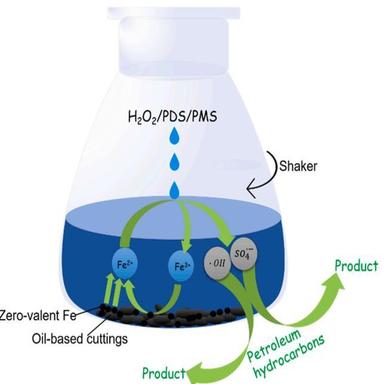
Schematic representation of the experimental set-up used for the degradation of petroleum hydrocarbons in OBDC by the Fe0 /PMS, Fe0 /PDS, and Fe0 /H2O2 advanced oxidation systems.